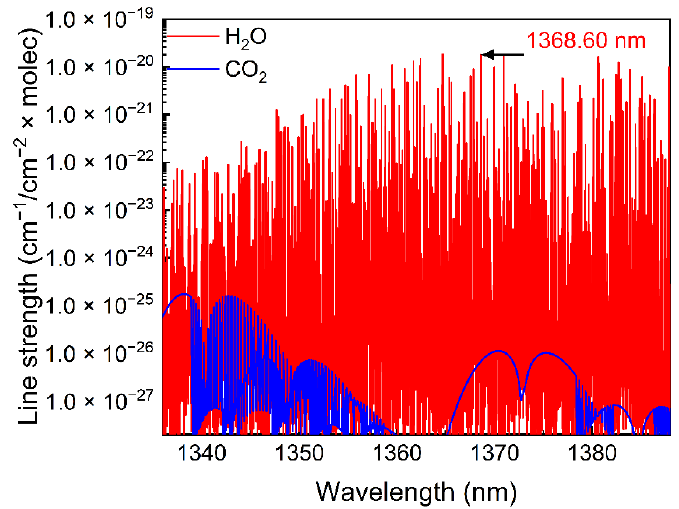
Figure 3. Simulations of line strength based on the HITRAN 2016 database.